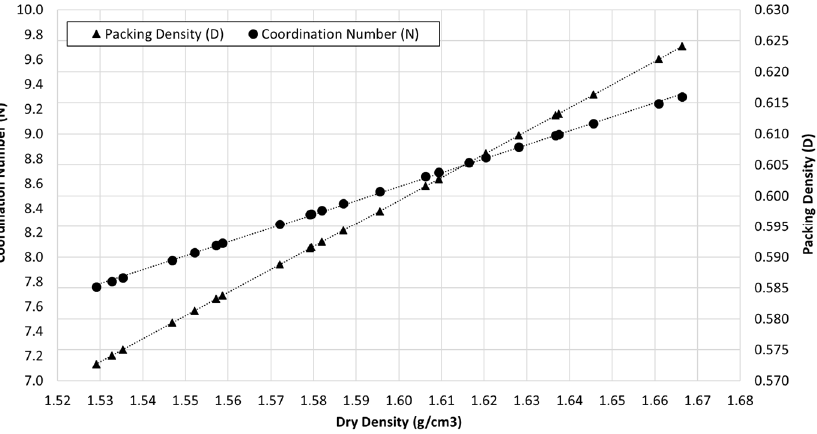
Figure 7. Variation of coordination number (N) for the values of dry density obtained after the compaction tests and adjusted trend expression.